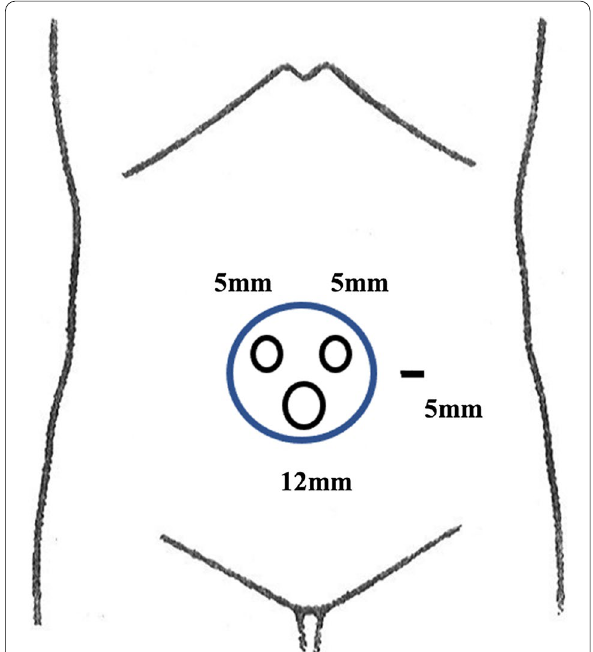
Fig. 1 Port placement. A 12-mm camera port and two 5-mm ports were introduced by Free Access device at umbilicus and a 5-mm port was inserted at left side of